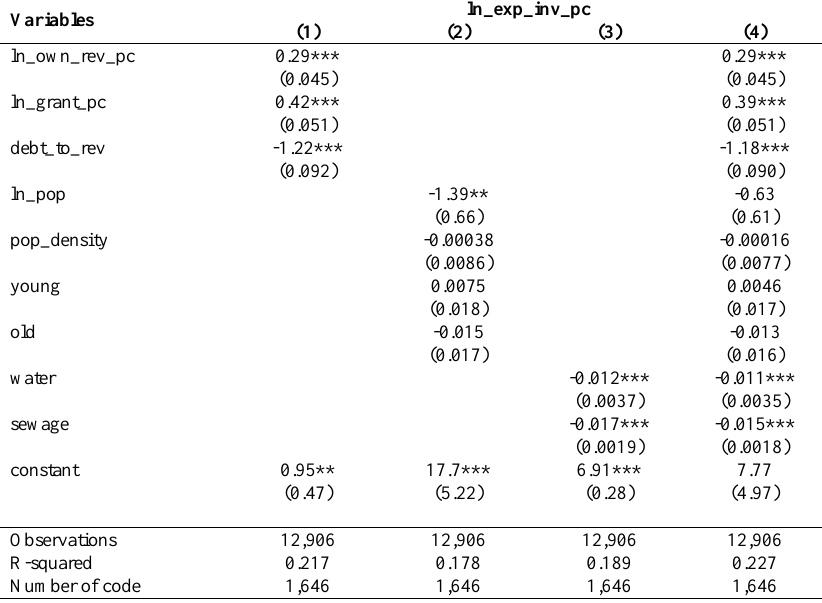
Table 5. Fixed effects (FE) regression results for municipalities with up to